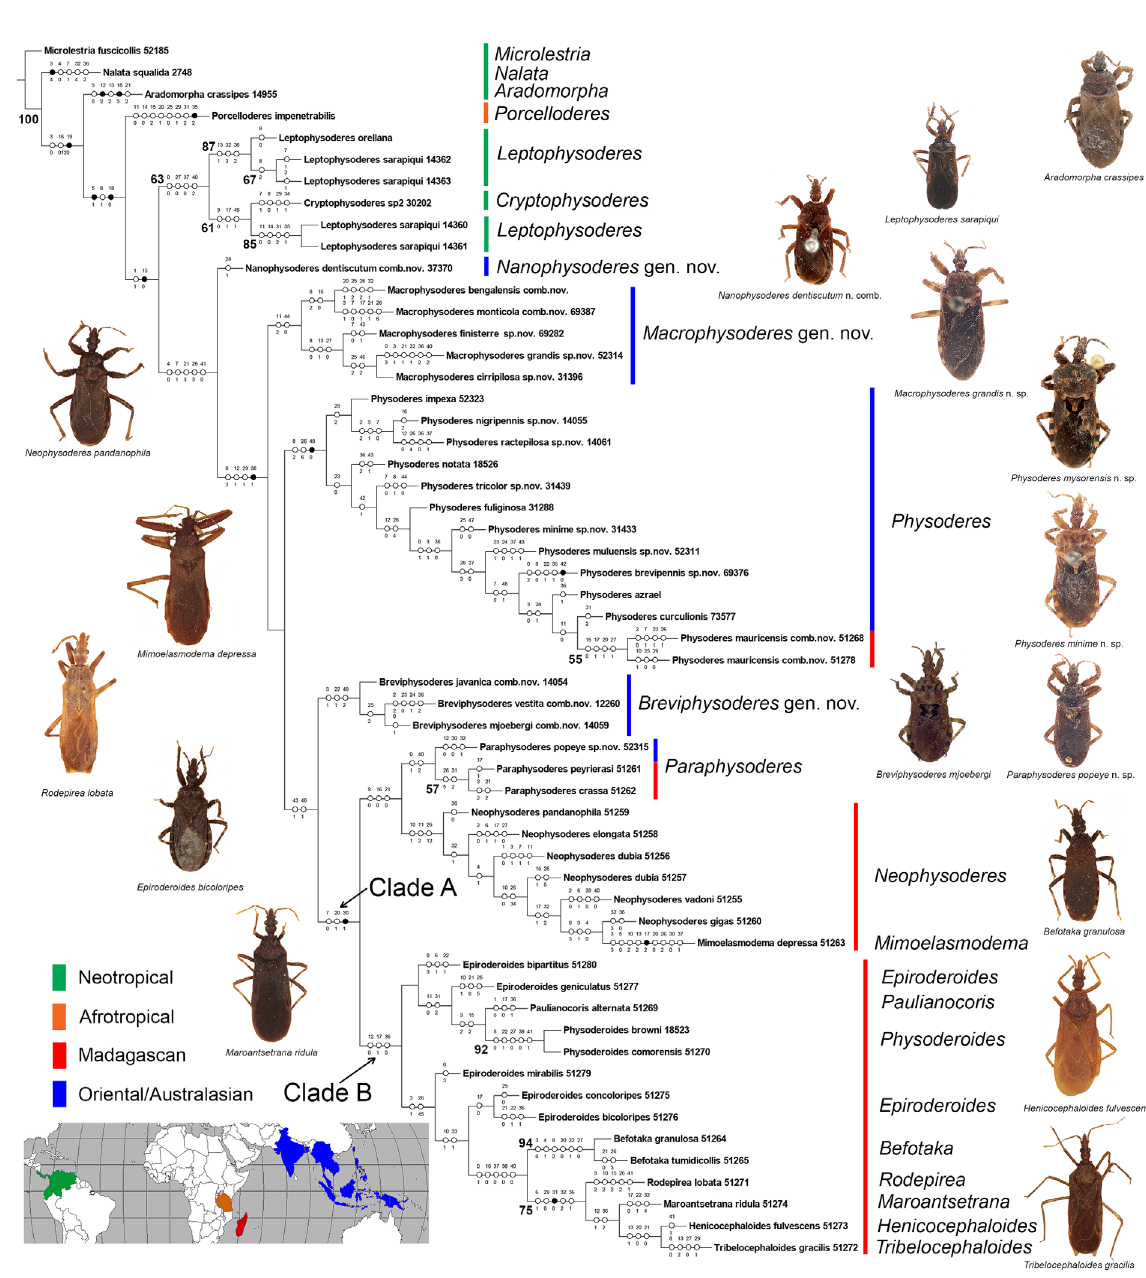
Fig. 2. Phylogeny of Physoderinae based on 57 morphological characters for 57 taxa analyzed using parsimony on TNT. Open white circles denote homoplastic characters, black circles denote characters that are not homoplastic. Numbers above the circles refer to character number (Table 1) and numbers below the circles refer to the character states (Table 3). Numbers in bold indicate symmetric resampling